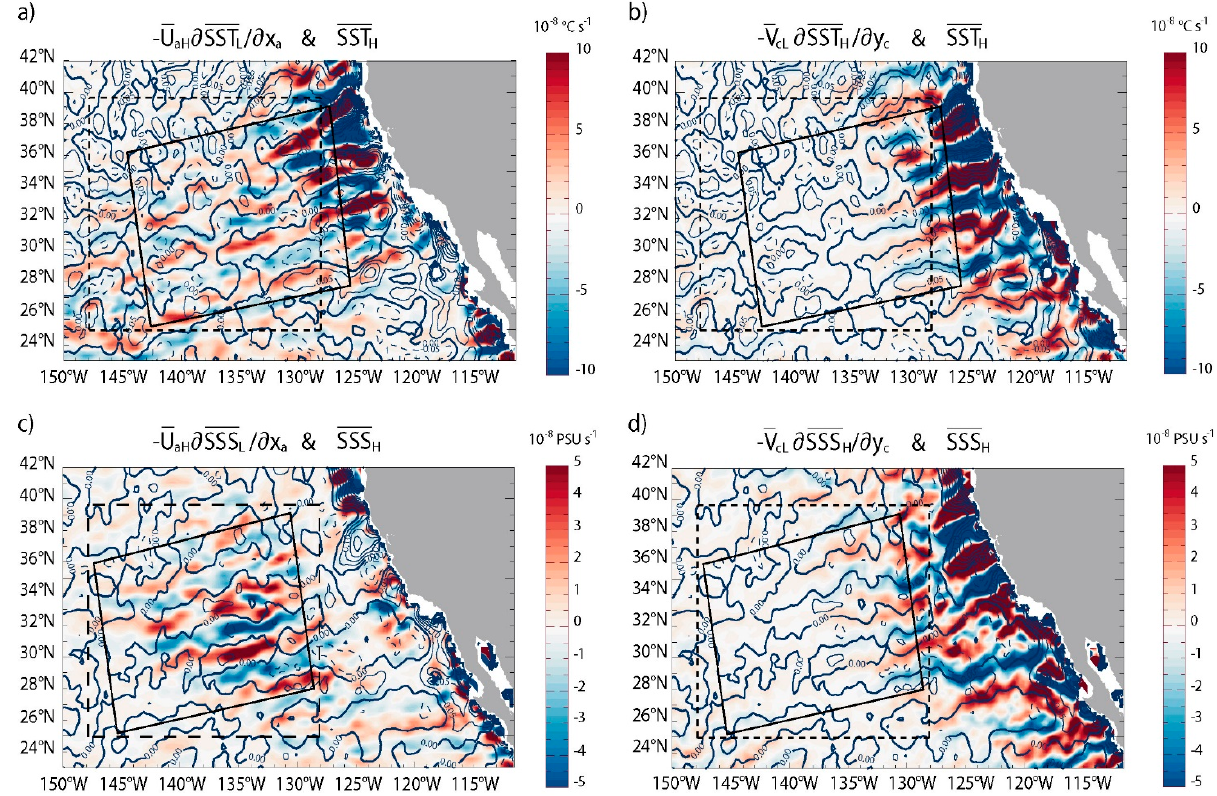
Figure 7. Advection of ( a , b ) SST and ( c , d ) SSS by striations in the ENP: ( a ) − U aH ∂ SST L / ∂ x a ; ( b ) − V cL ∂ SST H / ∂ y c (10 − 8 ◦ C s − 1 ); ( c ) − U aH ∂ SSS L / ∂ x a ; and ( d ) − V cL ∂ SSS H / ∂ y c (10 − 8 PSU s − 1 ). The contours (solid/dashed for positive/negative values) are for ( a , b ) SST H (CI = 10 − 2 ◦ C) and ( c , d ) SSS H (CI = 10 − 2 PSU). Solid and dashed boxes are as in Figure 2a,c, except that the solid boxes on the top panels are displaced 3 degrees